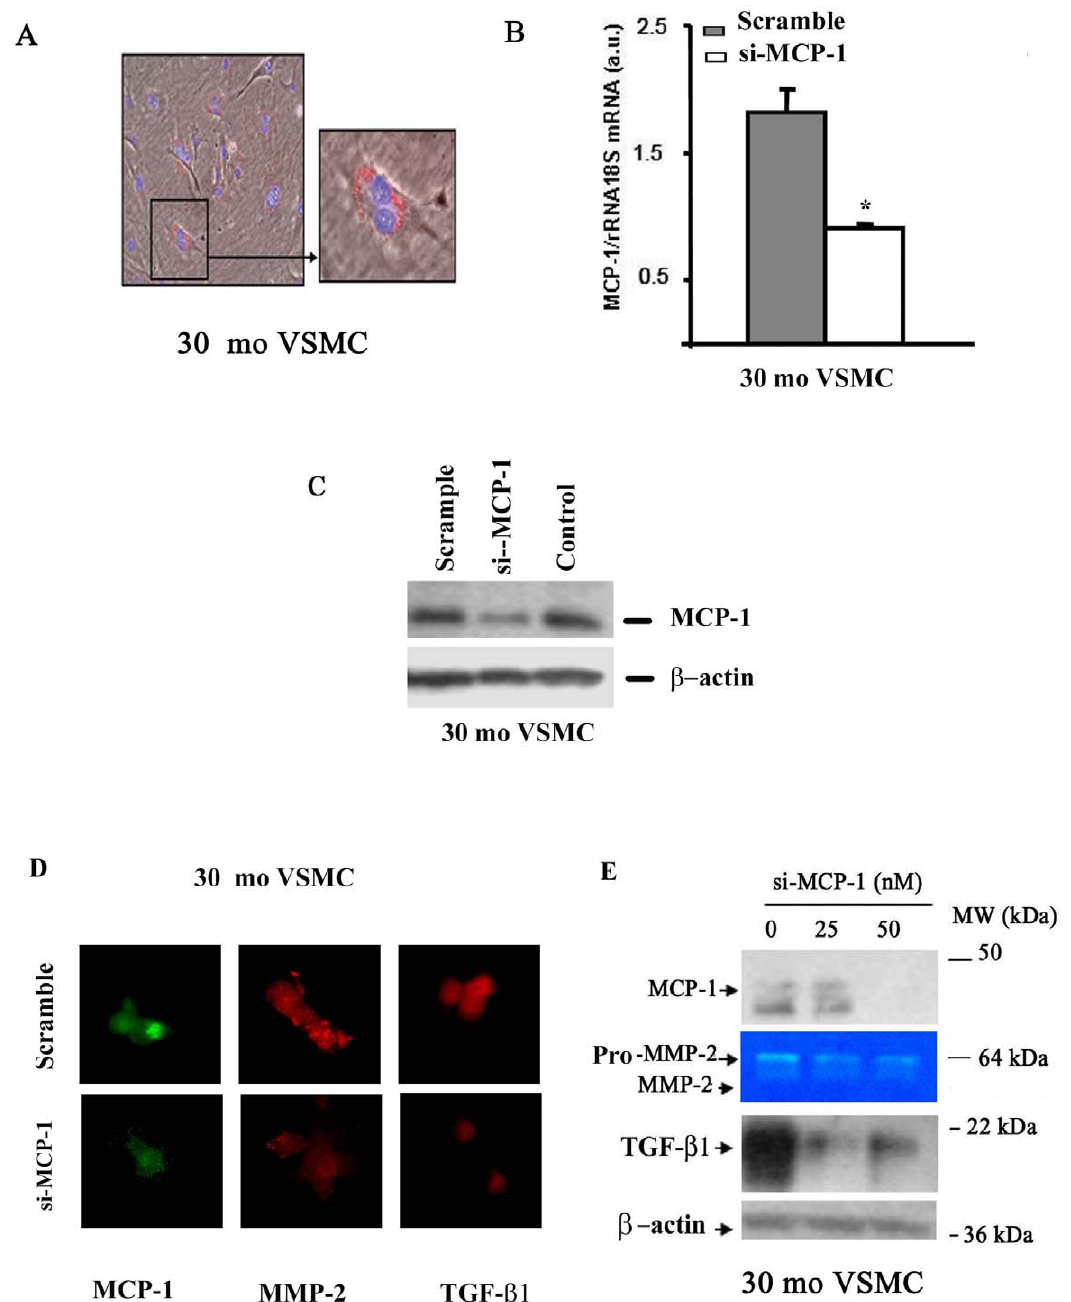
Figure 3. siRNA MCP-1. A. Photomicrograph of MCP-1 silenced VSMC. Inset showing enlarged image (X1000). B. qRT-PCR. *p , 0.05, siRNA MCP-1 vs. scramble in 30 mo VSMC. C. Western blots of MCP-1 in 30 mo VSMC (n=3). D . Immunofluoscence staining of MCP-1 (green), MMP-2 (red), and TGF- b 1 (red) (X400) in 30 mo VSMC treated with scramble (upper panels) and MCP-1 (50 nm, lower panels) siRNA. E. Representative of Western blots for MCP-1 and TGF- b 1 and PAGE gelatin zymograph. Similar results were obtained from at least 3 separate experiments. *p , 0.05 vs. scramble